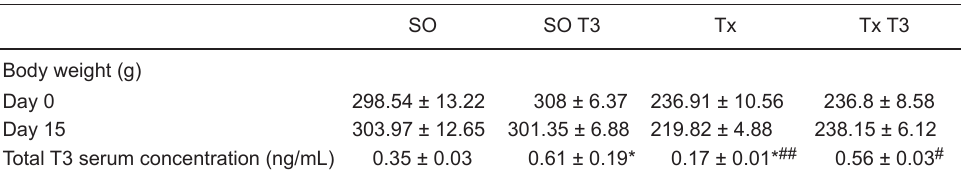
Table 1. Effect of triiodothyronine (T3) on body weight and serum T3 levels of sham-operated and thyroidec- tomized